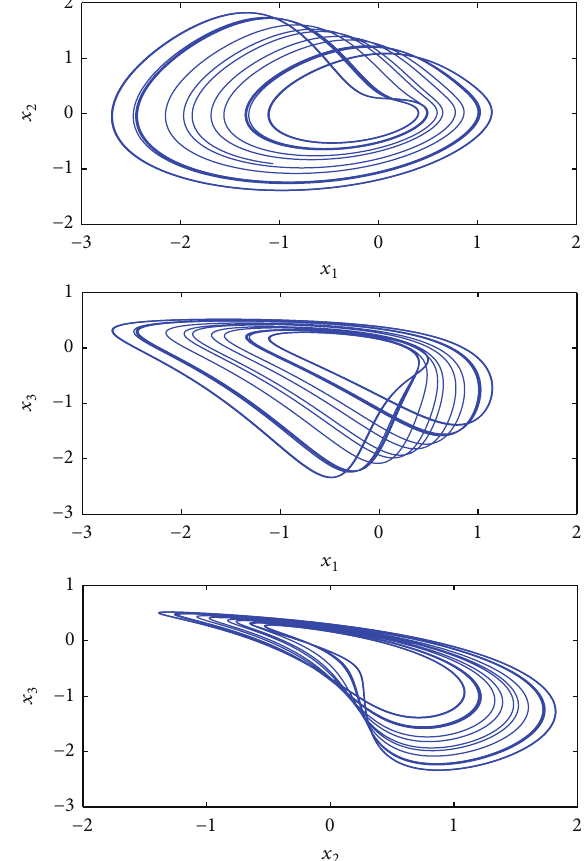
Figure 2: Chaotic attractor in the fractional-order Chua’s circuit (1) for 𝑞 = 0.98